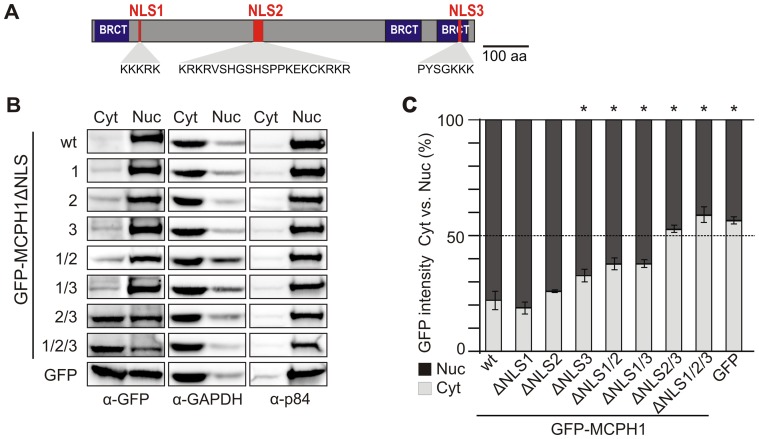
Nuclear localization signals (NLSs) in human MCPH1.(A) The positions of the putative NLS motifs and their amino acid sequences are highlighted in the diagram of the full-length MCPH1. (B) Subcellular distribution of GFP-tagged wild-type (wt) MCPH1 and mutants with deleted NLSs as indicated were transiently expressed in HeLa cells. Cytoplasmic (Cyt) and nuclear (Nuc) protein extracts were immunoblotted with an antibody against GFP (left panel). GAPDH (center panel) and the nuclear matrix protein p84 (right panel) served as index proteins and loading controls. (C) Ratios of relative GFP band intensity in the cytoplasmic (Cyt) vs. nuclear (Nuc) fractions. Absolute numbers were assessed using densitometry and normalized to the loading controls. Columns designate means, and error bars represent the S.D. from three different experiments. Significant differences to wt MCPH1 are indicated by asterisks denoting p<0.05 (Student's t-test). Scale bar = 10 µm.